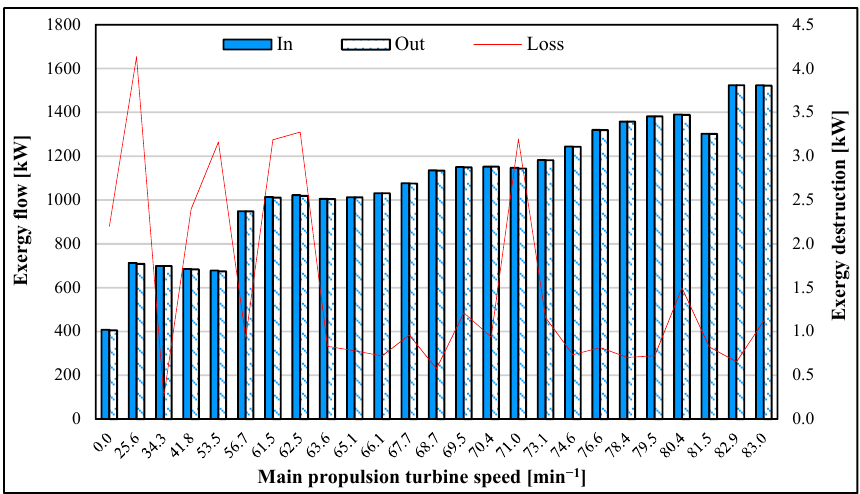
Figure 3. Energy flow of atmospheric drain tank with main turbine load variation.